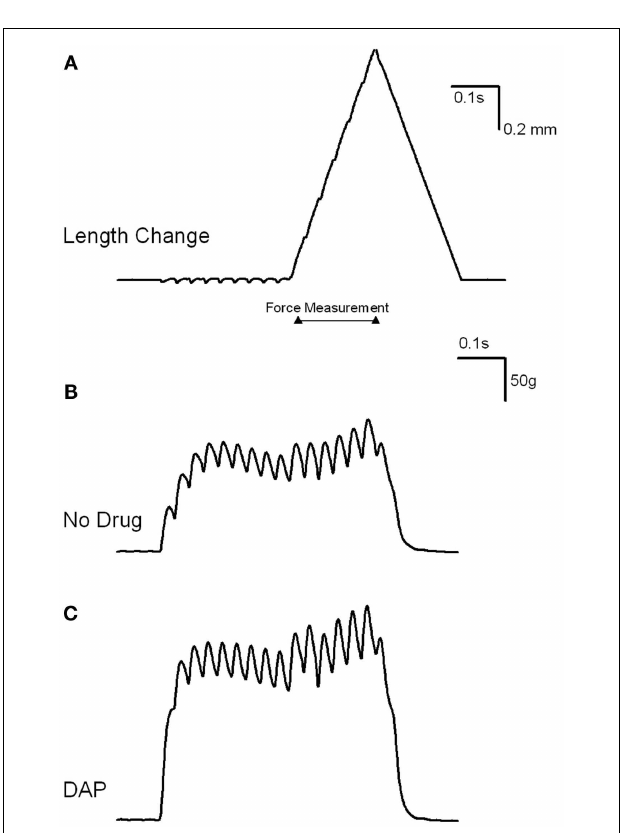
FIGURE 7 | Examples of load curve experiment. (A) Is an example of the length change from L 0 to + 1.2mm. After the first 300ms of the 500ms–30Hz train, the muscle length was changed at a velocity of 6mm/s. Peak force was measured while the muscle was being lengthened and stimulated (indicated by flat line). (B) Shows the resulting change in load after the addition of control saline. (C) Shows the resulting change in load after the addition of DAP.